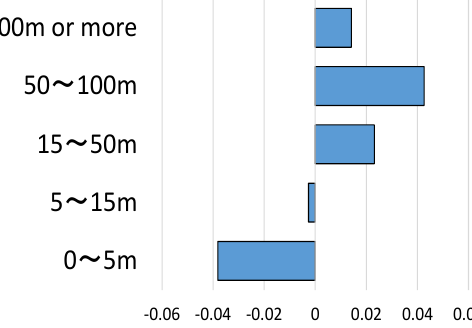
Figure 13. Bridge length category scores (bearings).